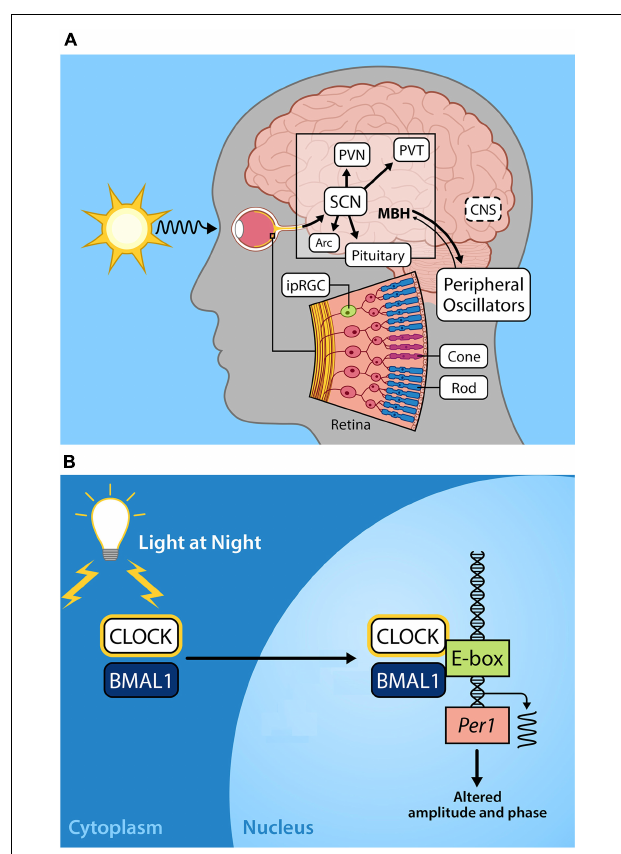
FIGURE 1 | (A) Light entrains the circadian clock. The light-dark cycle is the strongest zeitgeber, involved in synchronizing intrinsic circadian oscillations in the brain and periphery. Light energy in the form of photons enter the retina, depolarizing intrinsically photosensitive retinal ganglion cells (ipRGCs) which relay photic information via the retinohypothalamic tract to the so-called master circadian pacemaker, the suprachiasmatic nucleus (SCN) in the anterior hypothalamus. Direct and indirect projections of the SCN entrain other regions including local nuclei within the mediobasal hypothalamus (MBH), the paraventricular nucleus (PVN), paraventricular nuclei of the thalamus (PVT), arcuate nucleus (Arc). Endocrine signals from the pituitary gland and the pineal (melatonin secretion) that are initiated by the SCN provide time of day information to entrain peripheral oscillators. (B) Exposure to light at night disrupts the molecular circadian clock. The molecular clock in the cells of central and peripheral tissues is comprised of transcriptional-translational feedback loops. The positive arm of the core circadian feedback loop involves the protein products of the genes circadian locomotor output cycles kaput (CLOCK) and brain and muscle arnt-like protein-1 (BMAL1), which heterodimerize in the cytoplasm, translocate to the nucleus, and bind to the E-box promotor regions of Period (Per) and Cryptochrome (Cry), driving their transcription. In the negative feedback arm of the core circadian feedback loop (not shown) Per/Cry protein products translocate to the nucleus to repress CLOCK/BMAL transcriptional activation, cycling with a period lasting approximately 24 h (please see Hurley et al., 2016; Rumanova et al., 2020) for further details on the molecular circadian clock). Exposure to light during the night disrupts Per1 expression resulting in altered circadian amplitude and